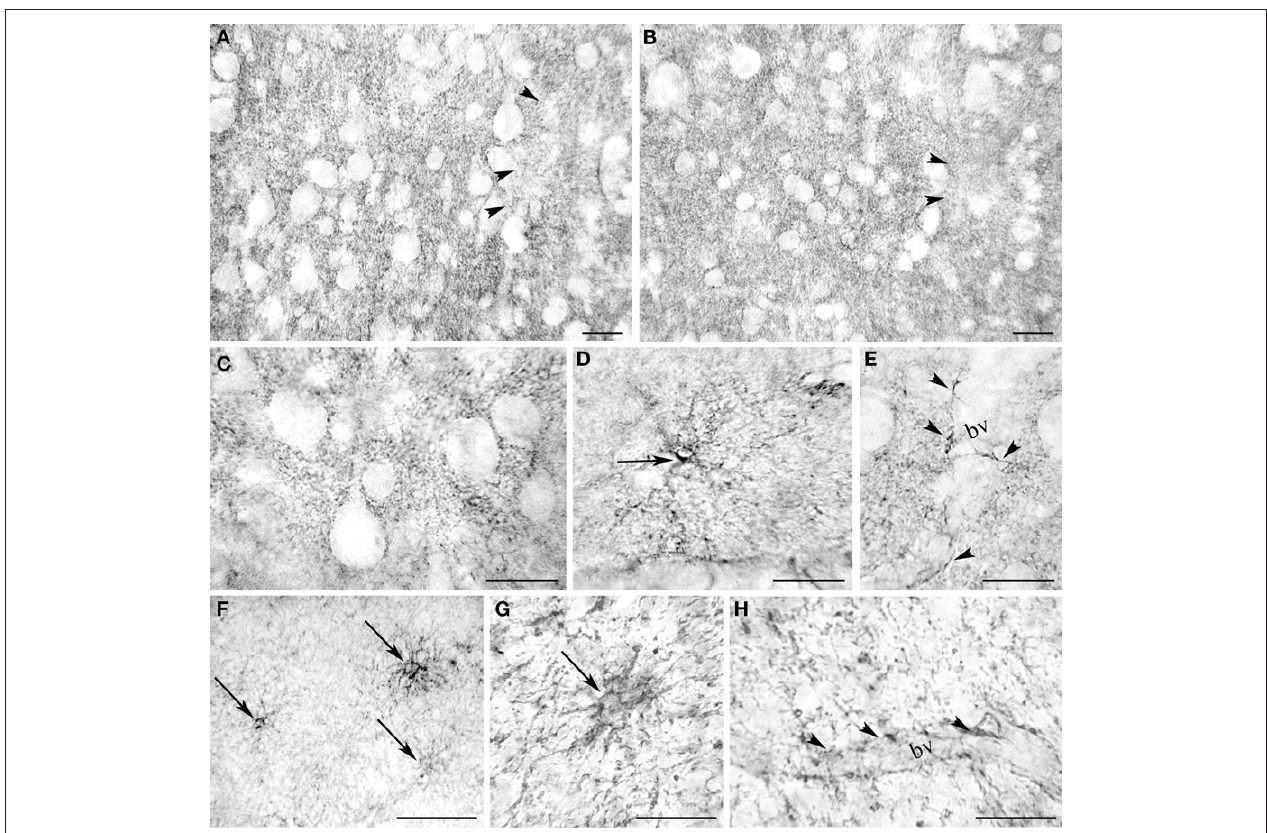
underlying the cortex (area 32; HBC 970105) EAAT2a-ir is in cells resembling astrocytes (F,G) and in perivascular profiles (H) . bv, blood vessel. Arrowheads in (A,B) indicate patchy areas of limited EAAT2a-ir; arrows in (D,F,G) point to intensely stained astrocyte-like cells; and arrowheads in (E,H) indicate EAAT2 ir perivascular profiles. Scale bars: 20 μm for (A–E,G–H) ; 50 μm for (F)